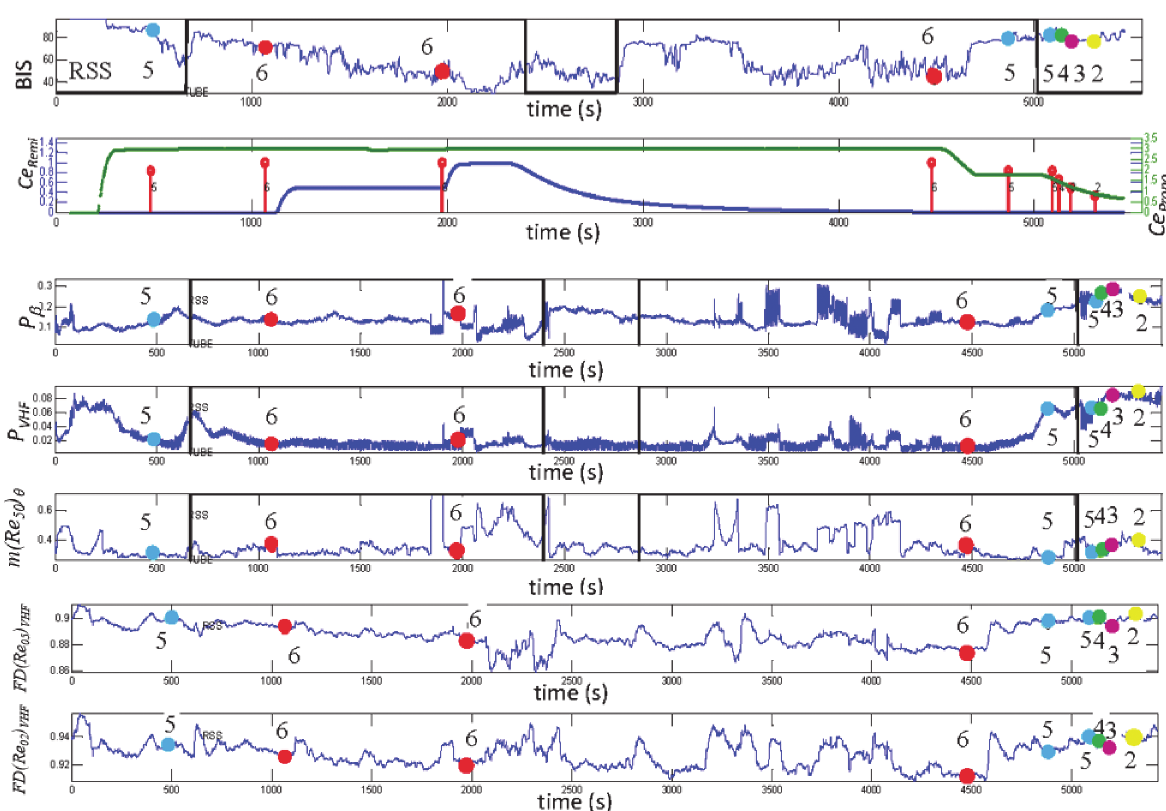
Fig 5. Time evolution of EEG measures. Example of time-evolution of bispectral index (BIS), predicted effect site remifentanil (Ce Remi (ng/ml)) and propofol (Ce Propo ( μ g/ml)), mean value of AMIF in θ band for q = 50, power spectral density in β band, power spectral density in VHF (105 – 145 Hz) band, first decay of Auto-Mutual Information Function (AMIF) in VHF (105 – 145 Hz) band for q = 0.5 and first decay of AMIF in VHF (105 – 145 Hz) band for q = 0.2 of a patient entire recording. All the EEG measures are represented in arbitrary units. Black vertical line represents the tube insertion, GAG = 1 in the first insertion and GAG = 0 in the second insertion. RSS annotation are represented with yellow (RSS = 2), pink (RSS = 3), purple (RSS = 4), blue (RSS = 5) and red (RSS = 6)